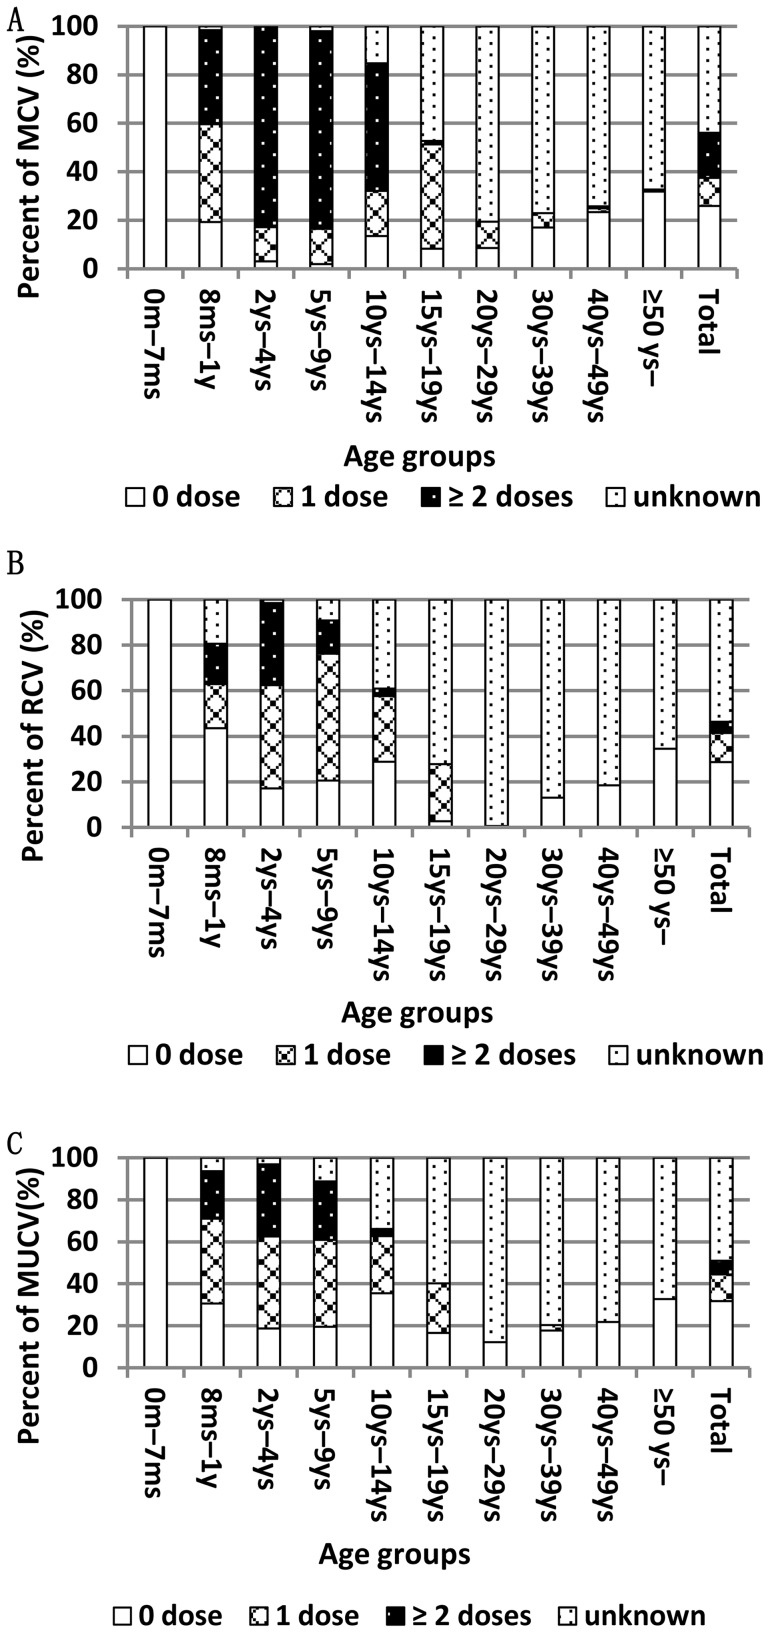
Percentage of vaccination history with different dose by age in 2011.Approximately 90% of children aged <14 years old received at least one dose of MCV and 70% was immunized with two doses (A). However, adults aged >15 years reported with lower coverage of RCV (B) and less than one half of children aged 5–9 years were recorded with two dose of MuCV (C). MCV: measles-containing vaccine; RCV: rubella-containing vaccine; MuCV: mumps-containing vaccine.